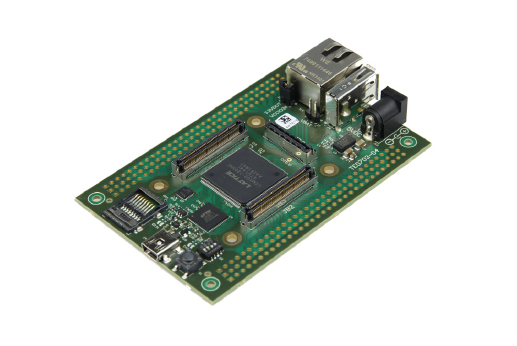
Figure 11: TE0703 carrier